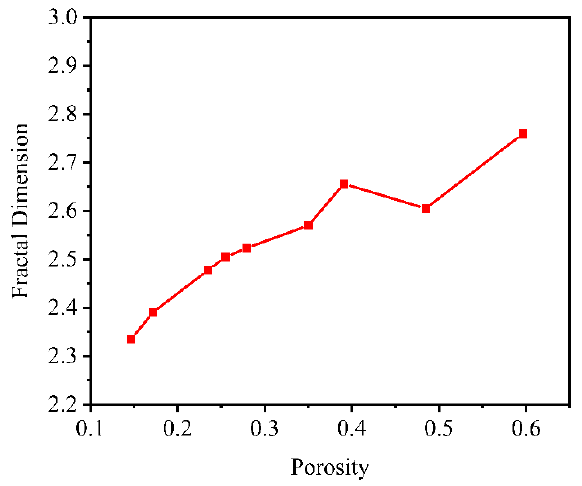
Figure 14. Porosity vs. fractal dimension.